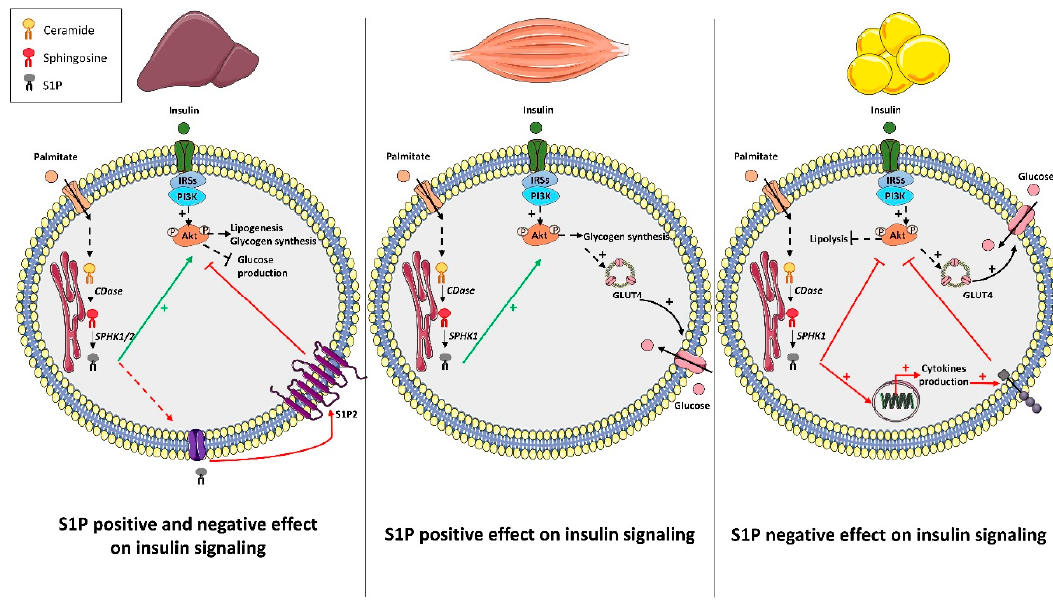
Figure2. RoleofS1Pmetabolismoninsulininperipheraltissuesinresponsetopalmitate. Figure 2. Role of S1P metabolism on insulin in peripheral tissues in response to palmitate . In hepatocytes, palmitate increases intracellular S1P content through SphK1/2 activities. According to